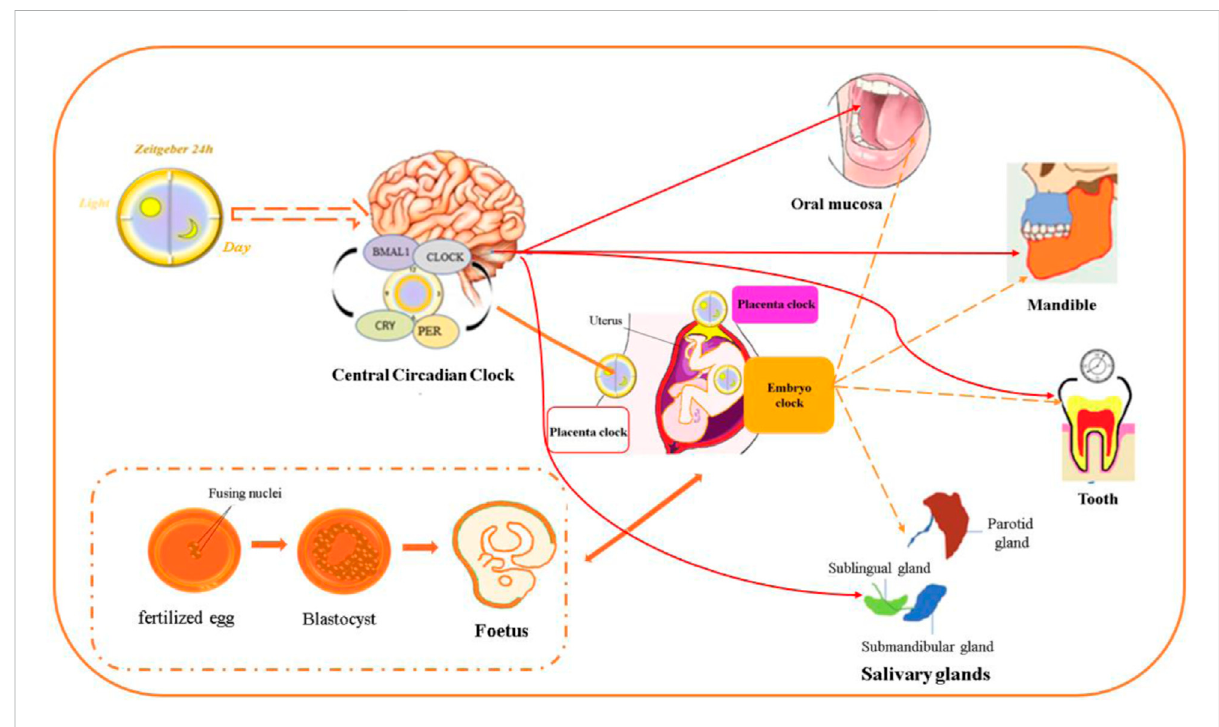
Circadian clock genes are expressed in the oral and maxillofacial region. The circadian clock regulates development in different stages of the embryonic period and postnatal stage. Circadian clock gene expression was detected in the maxillomandibular region, teeth, salivary glands, oral epithelium and periodontal tissue, which comprise the oral and maxillofacial